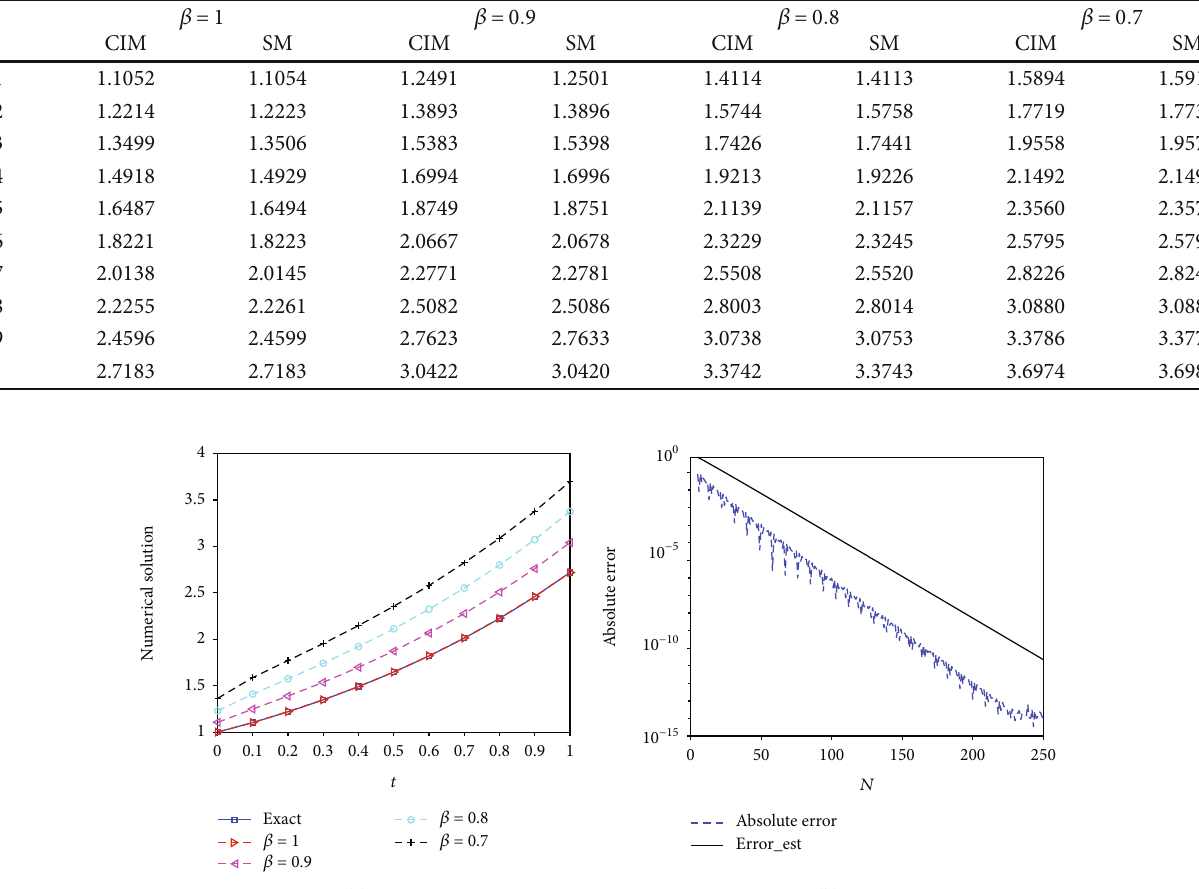
Figure 4: In (a), absolute error versus t for β = 1 corresponding to Problem 2 is shown. In (b), the plot of error versus N for β = 1 is shown. Table 4: The approximate solutions for di ff erent values of β using the two numerical schemes N = 240 , M = 22 , corresponding to Problem 3.